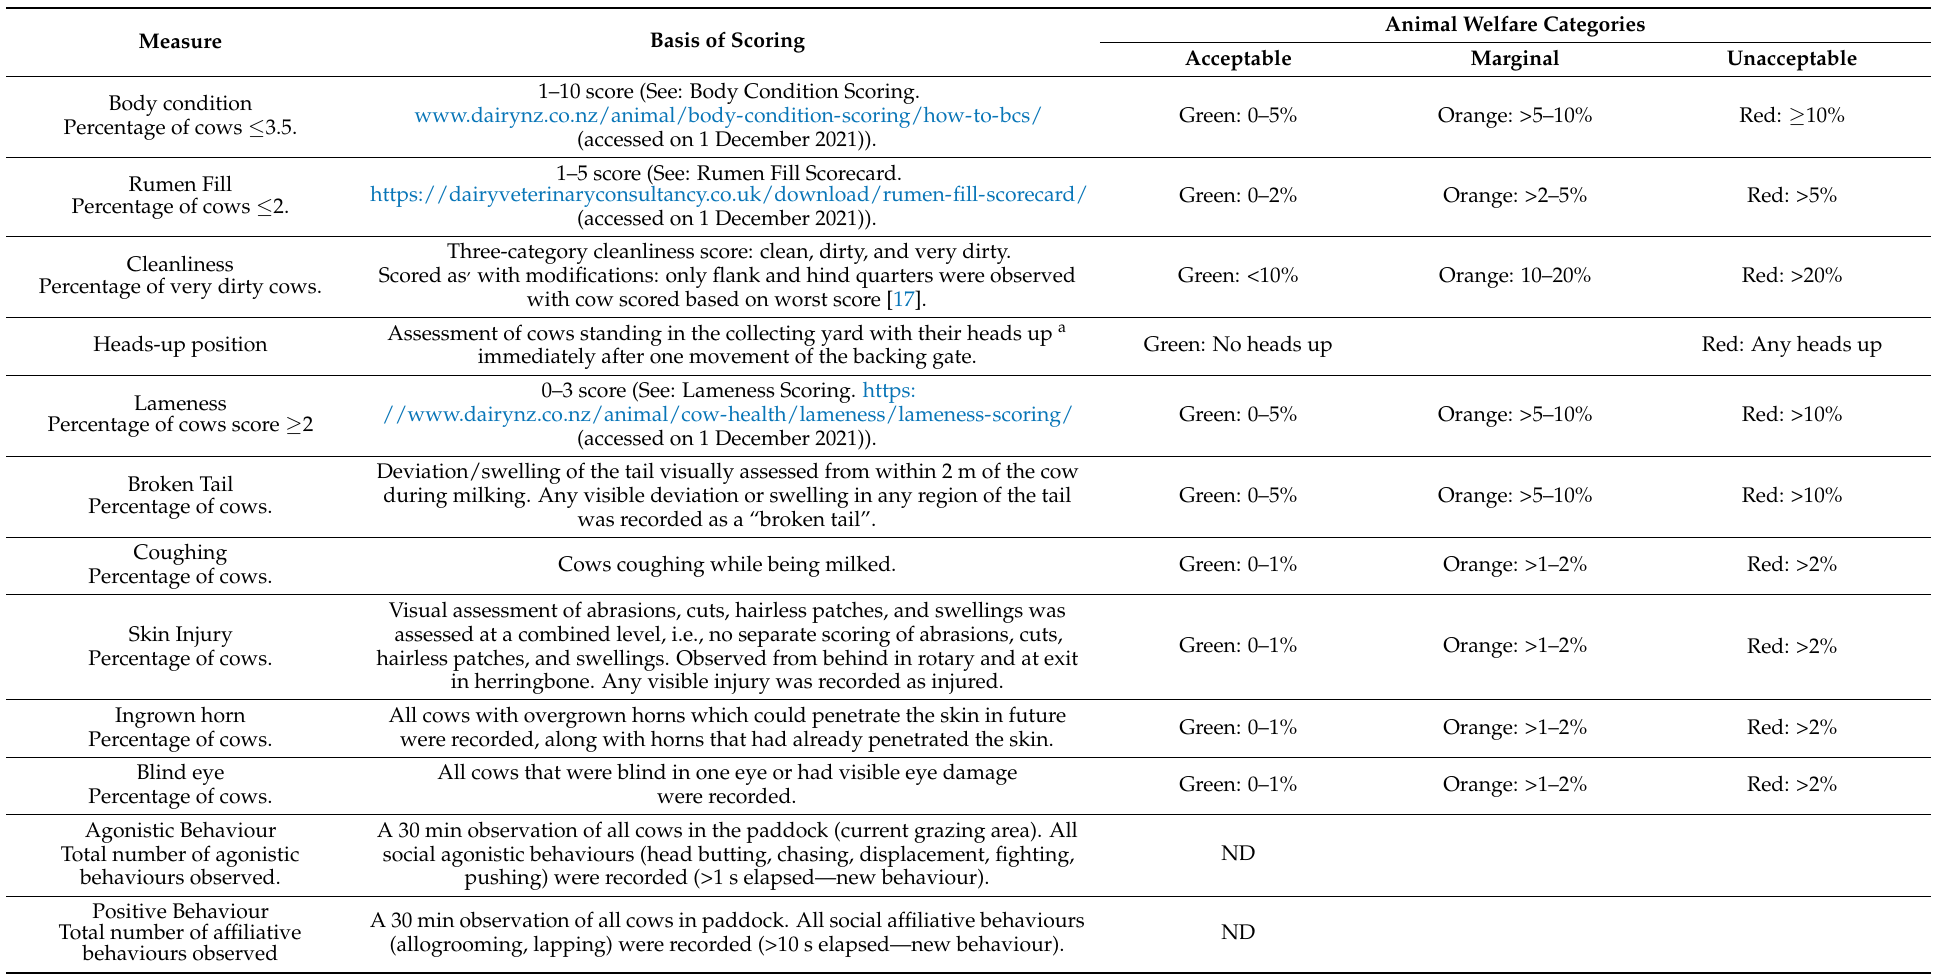
Animal Welfare Categories Acceptable Marginal Unacceptable